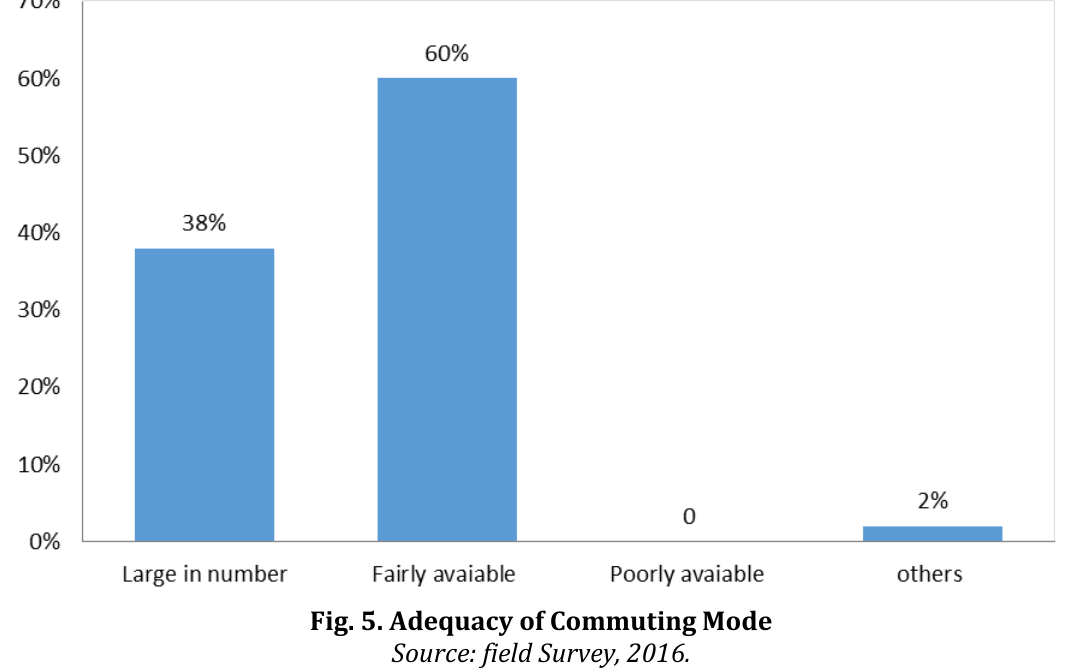
Fig. 5. Adequacy of Commuting Mode Source: field Survey,